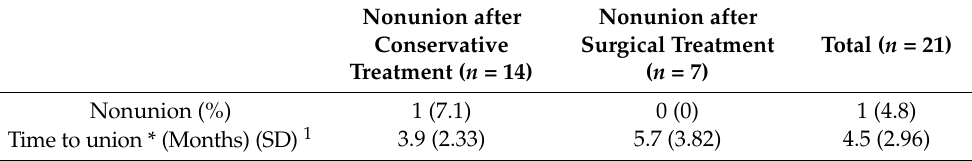
Table 3. Pain and functional questionnaires.